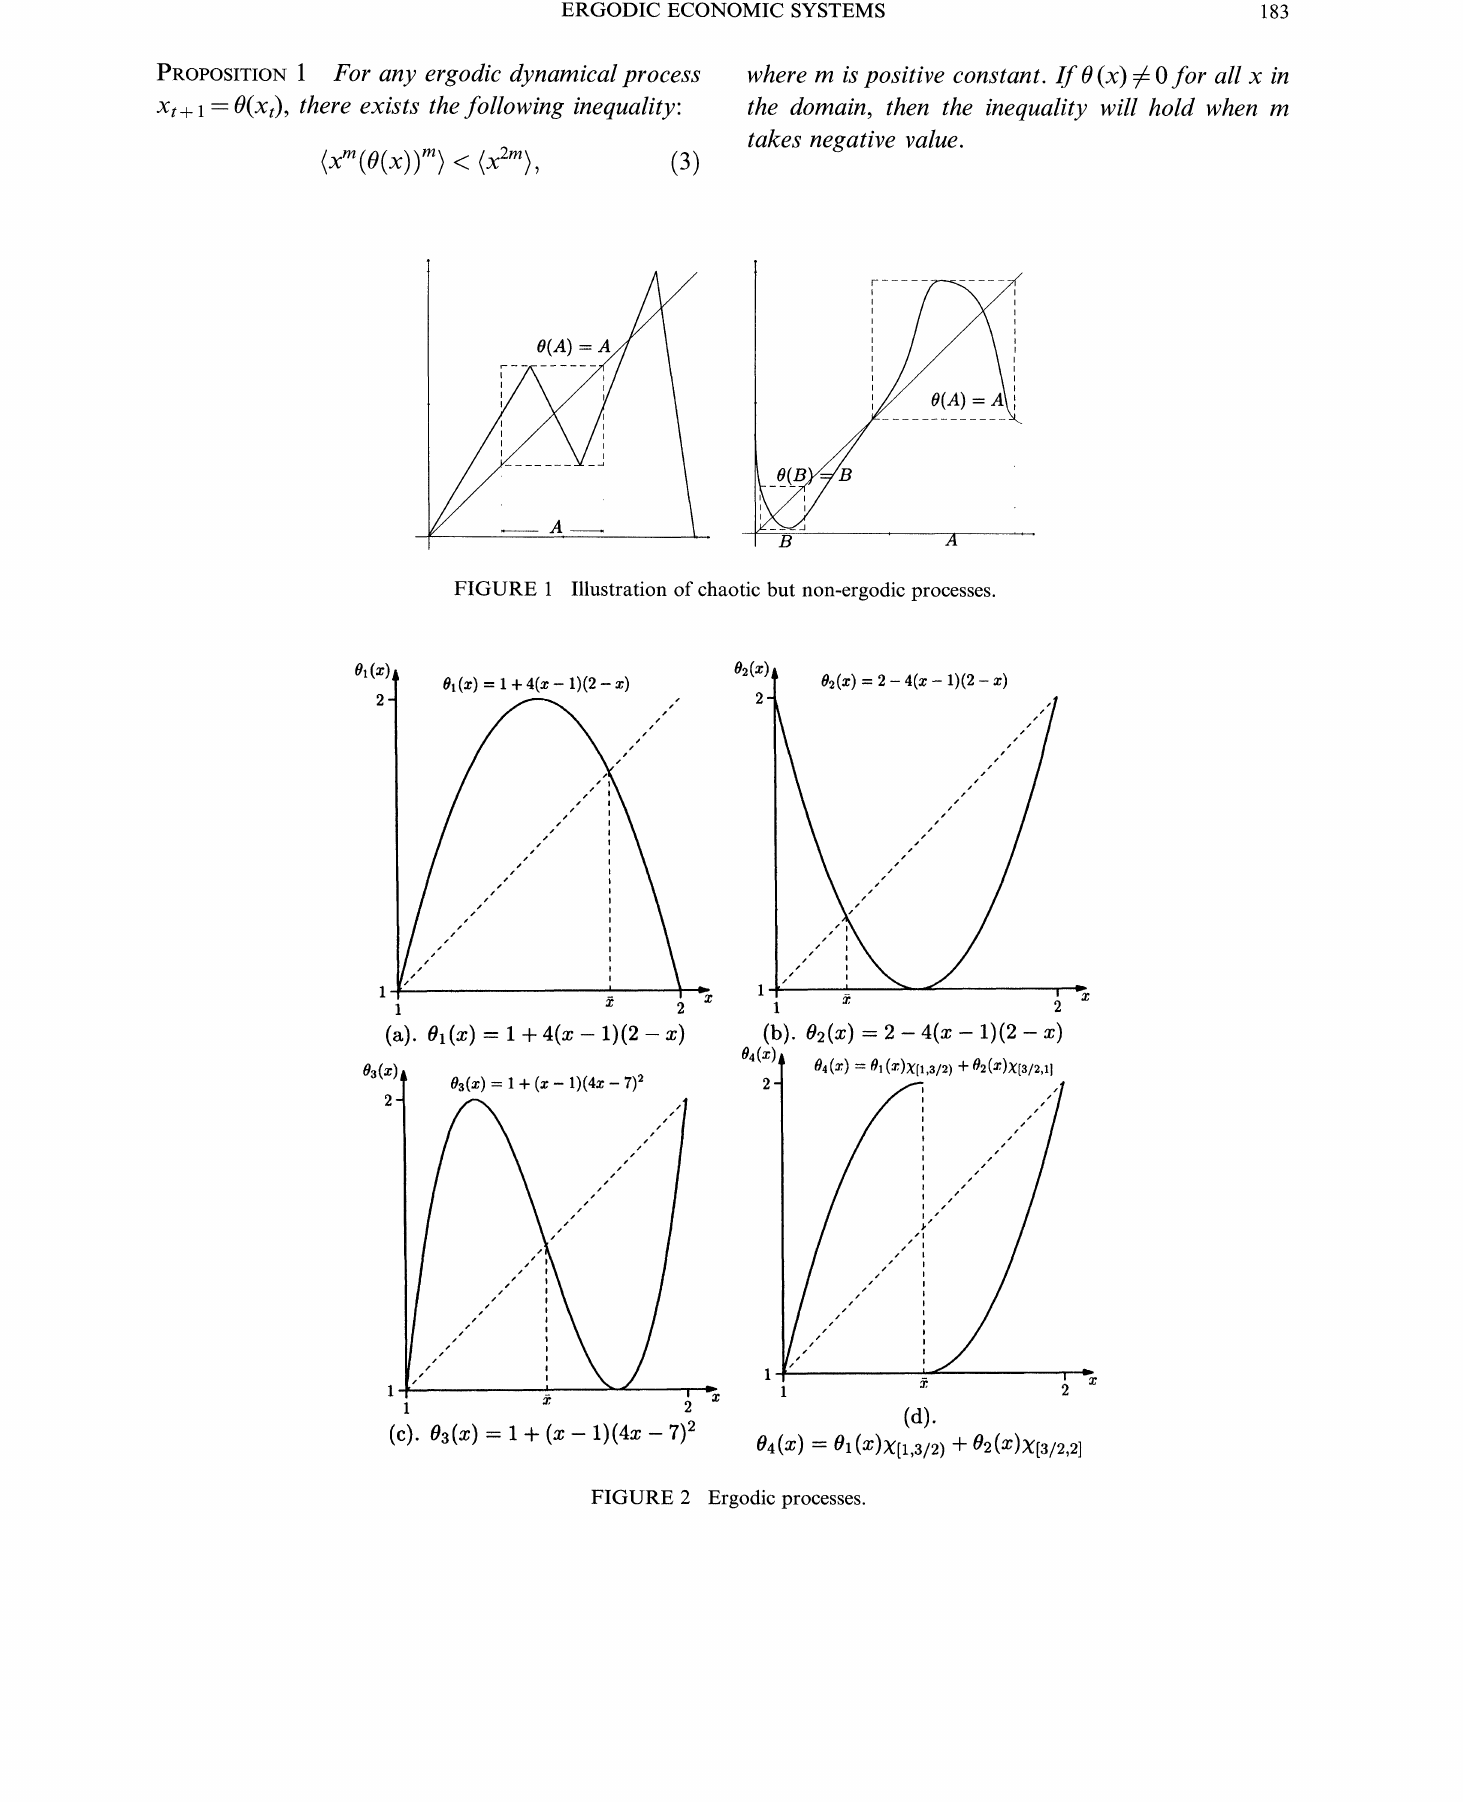
FIGURE 2 Ergodic